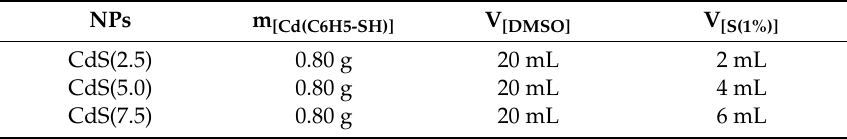
Table 1. Summary of the quantities used in the synthesis process of the CdS